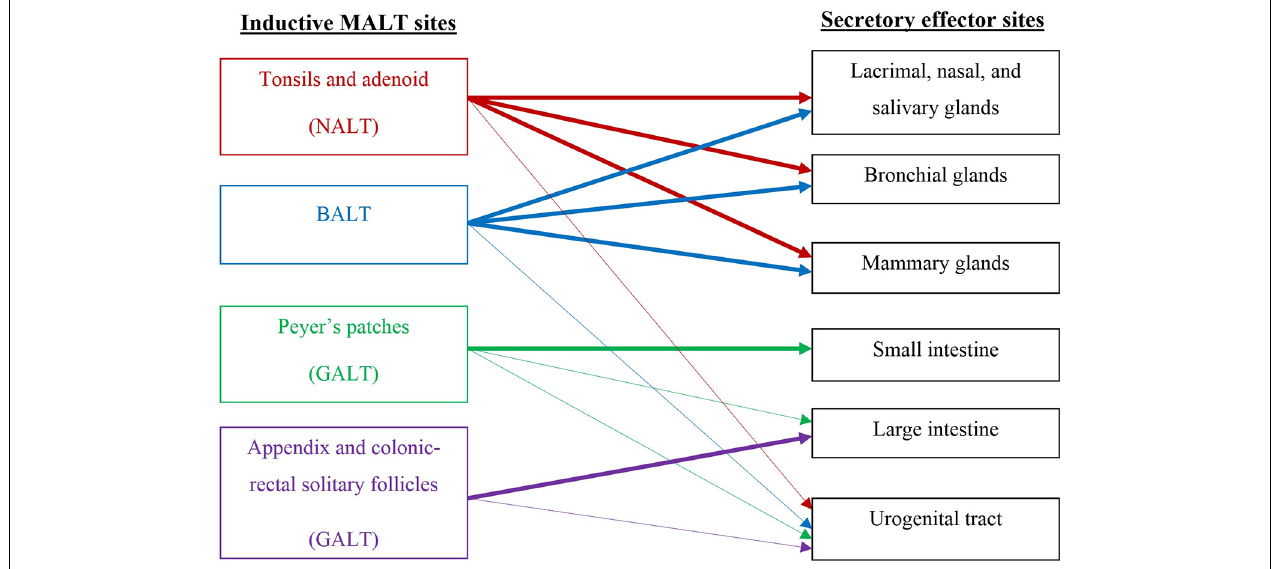
FIGURE 1 | Schematic of the common mucosal immune system (CMIS) relevant to the stimulation of vaccine-induced responses in the female genital tract.